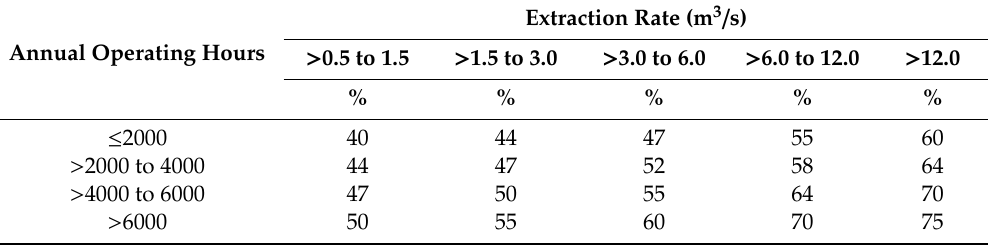
Table A3. Recovery e ffi ciency